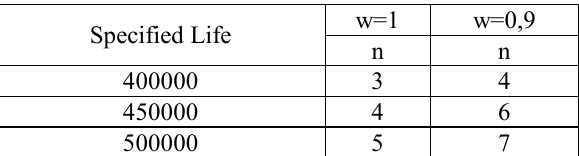
Table 8. Required number of inspections for non –